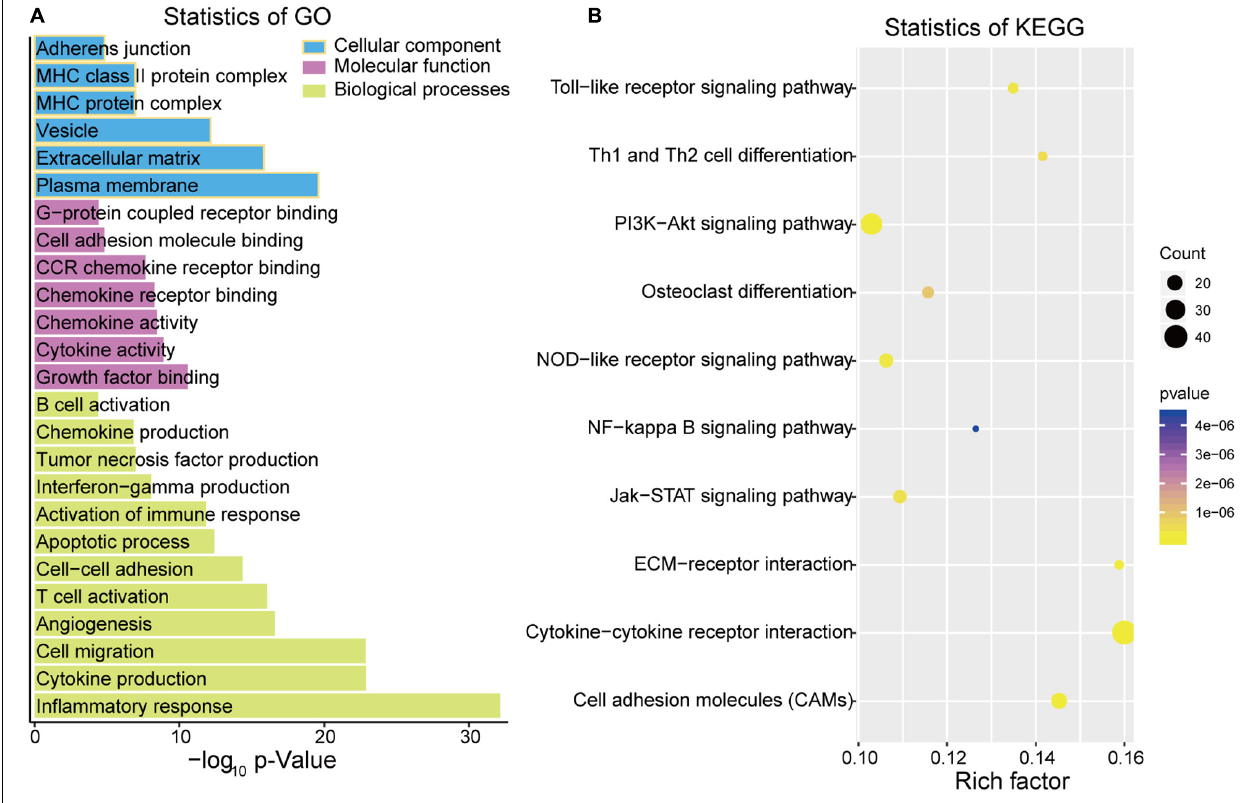
FIGURE 3 | Function analysis of DEGs by Gene Ontology (GO) (A) and Kyoto Encyclopedia of Genes and Genomes (KEGG) (B)